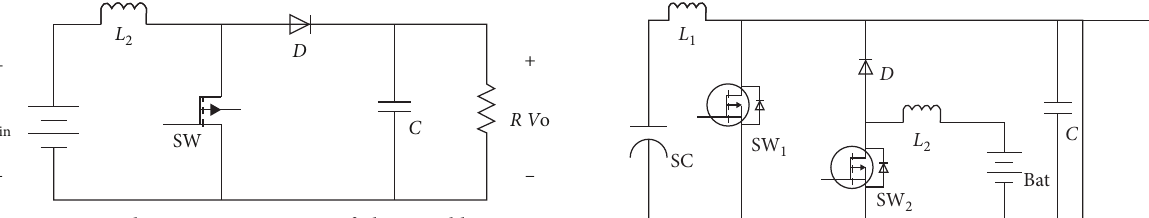
Figure 3: Equivalent Boost converter of the variable structure